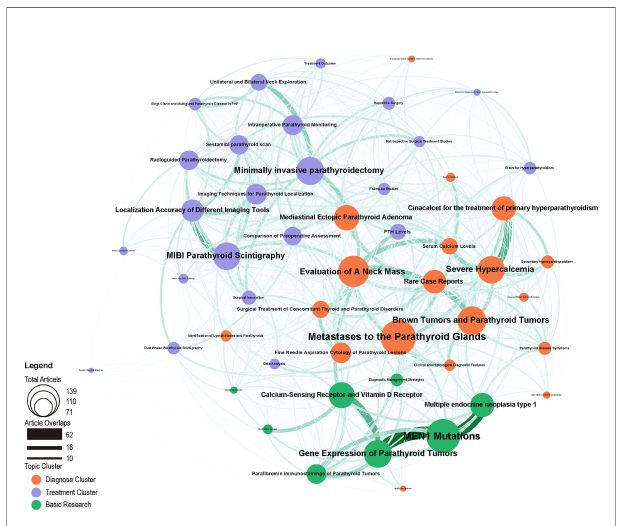
FIGURE 7 | LDA research topic cluster network: inter-and intrarelationships. For each topic, the size of the bubbles represents the number of articles associated with it. The lines between the bubbles indicate that the two topics contain articles that use common terminology, and their thickness represents the size of the relationship between the topics. Different colors represent different clusters, orange for diagnosis, purple for treatment, and green for basic